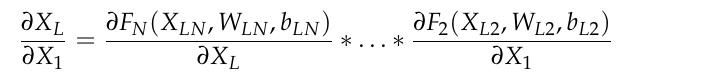
Figure 6. Adding SAM based on the residual structure.